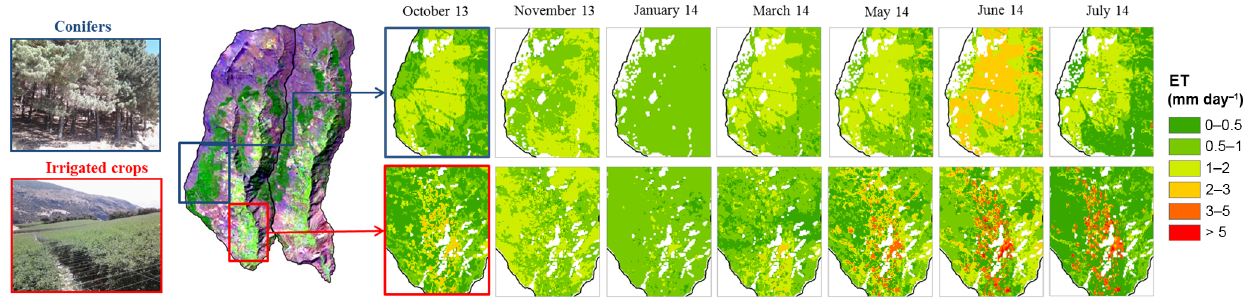
Figure 2. Evolution of the distributed values of daily ET over areas with two representative vegetation: conifers (dark-blue line) and irrigated horticultural crops (line red) for Bérchules watershed.